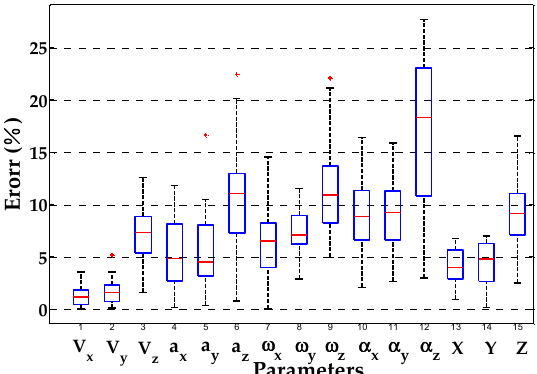
Figure 9. Biases of the extracted kinematic parameters.